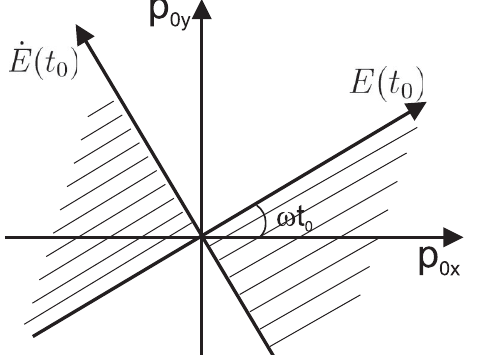
FIG. 1. The sign of _ (cid:5) e ð t Þ along the particle trajectory at t ¼ t 0 in different zones of the p 0 x p 0 y plane. The shaded zones corre- spond to acceleration (increase of (cid:5) e ) of positrons and electrons.